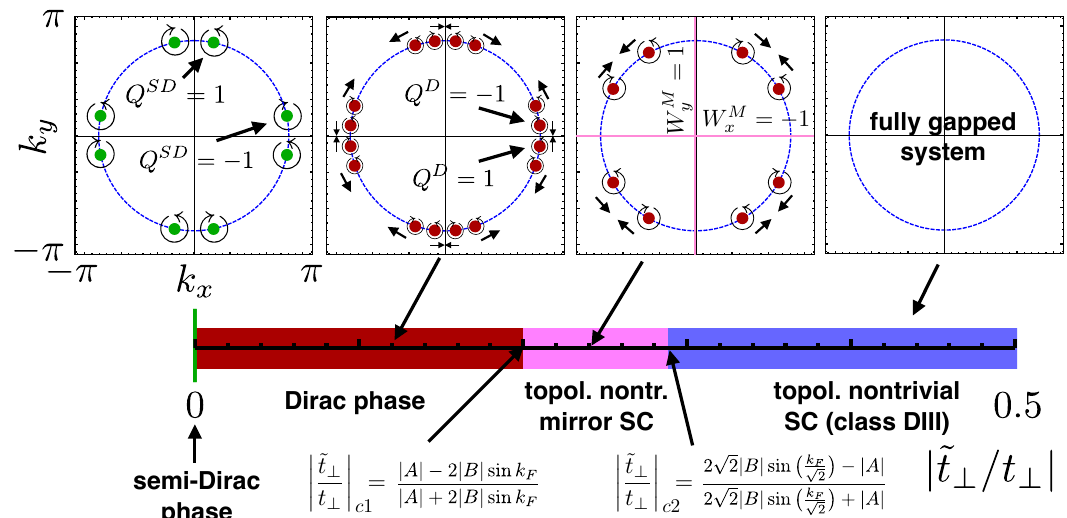
Figure 5: Phase diagram for the system described by the Hamiltonian (24) as a function of the parameter | ˜ t ⊥ / t ⊥ | describing the breaking of the protection of the semi-Dirac points. The = 5 π/ 6 are chosen so that for | ˜ t / t | = 0 the system is in parameters | A / B | = 1.5 and k ⊥ ⊥ F the semi-Dirac phase [ Eq. (21) ] . For | ˜ t ⊥ / t ⊥ | = 0 (within the constrained parameter